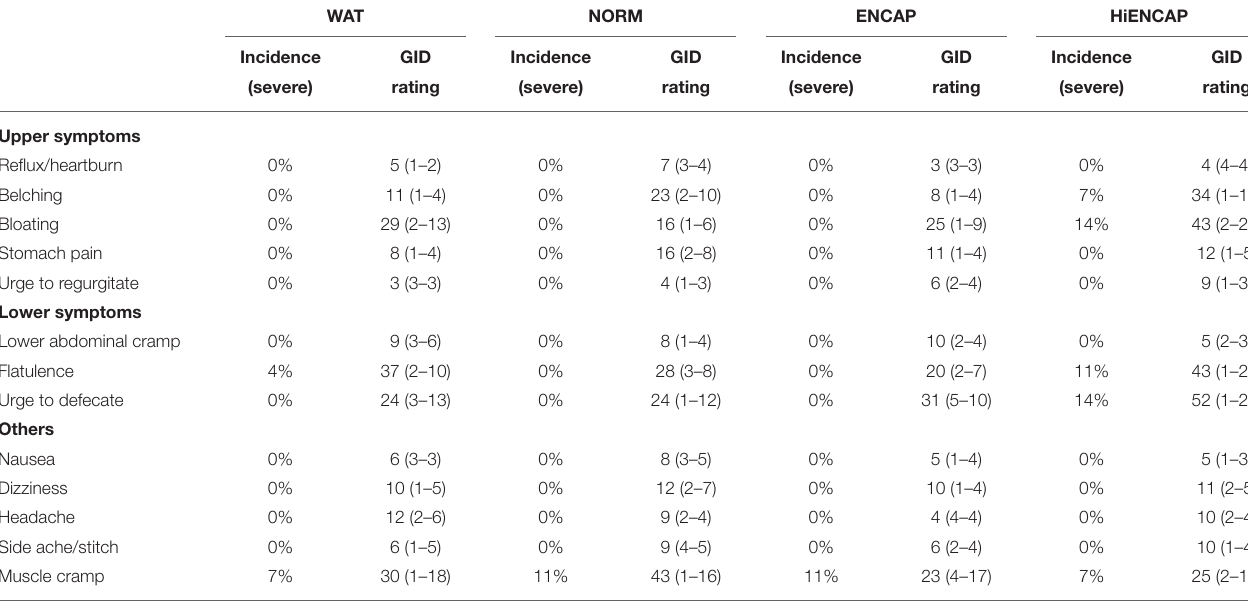
TABLE 2 | Values are overall summative accumulation scores for each trial of all those participants who reported a symptom ( n = 7), and the range of summative scores for individual participants is shown in